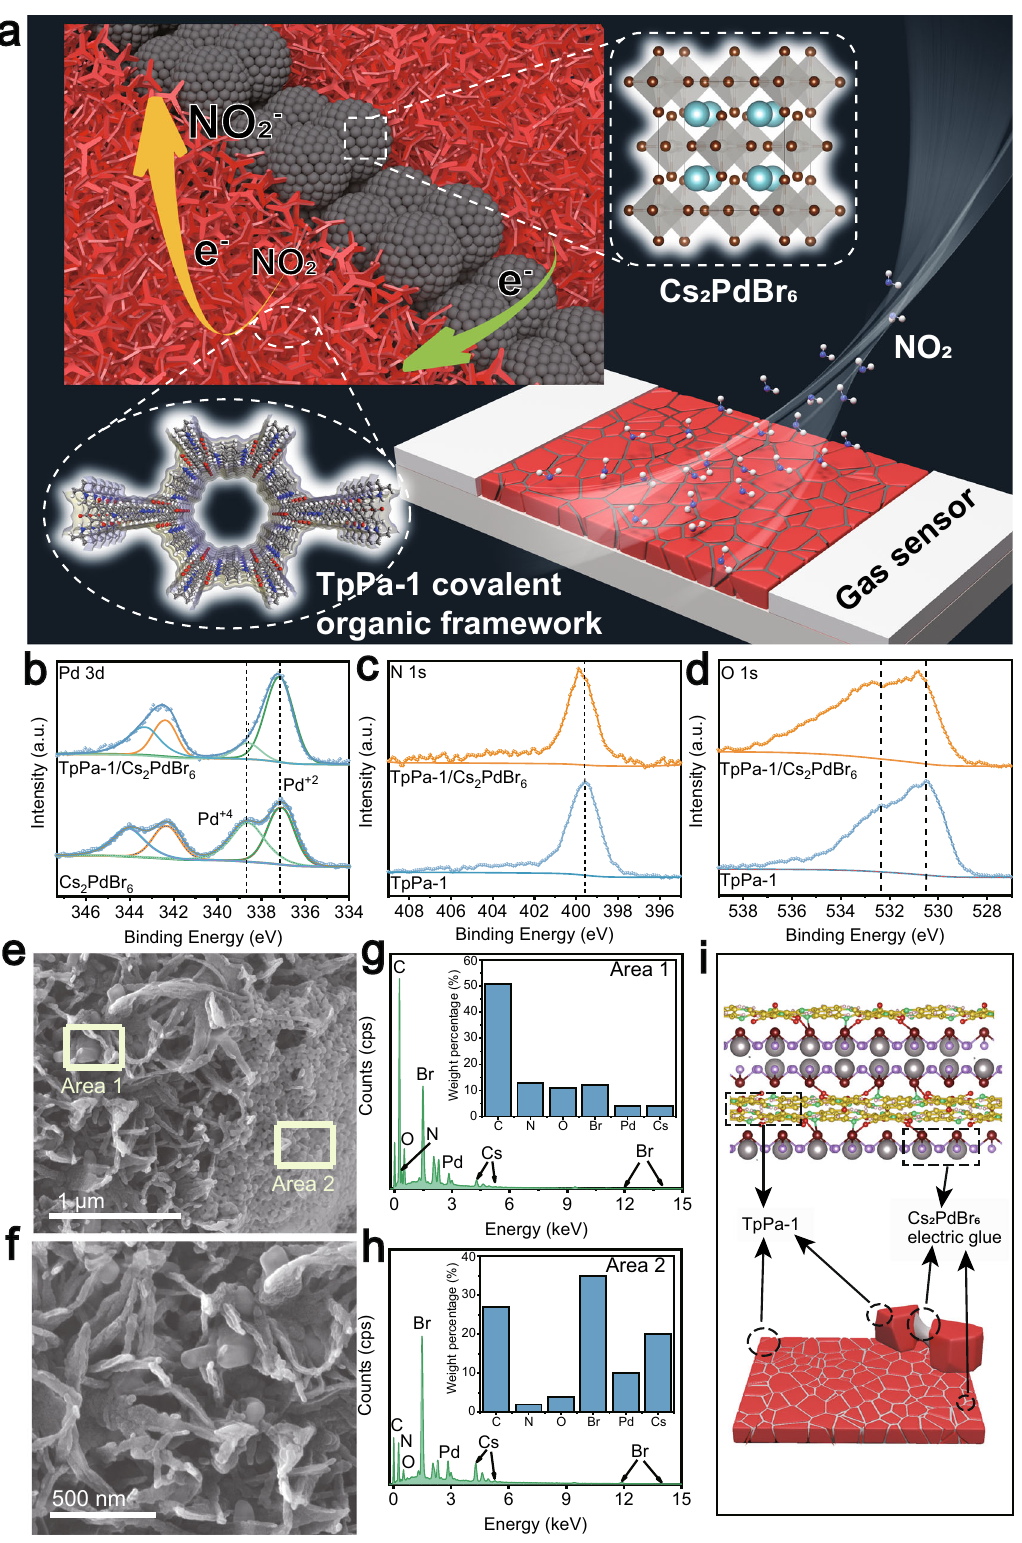
Fig. 1 | Structure and characterization of electric glues bond 2D COF crystal- lites. a Schematic diagram of the gas sensor and perovskite glue to bond COF crystallites. b XPSspectraofthePd3 d regionofCs 2 PdBr 6 andTpPa-1/Cs 2 PdBr 6 ; c N 1 s and d O 1 s region of the TpPa-1 and TpPa-1/Cs 2 PdBr 6 . e , f FSEM images and